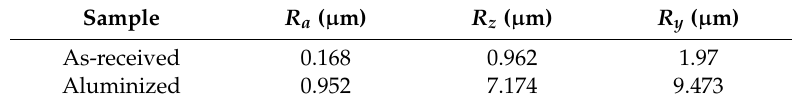
Table 4. Surface roughness for samples in the condition of as-received steel and aluminized steel.